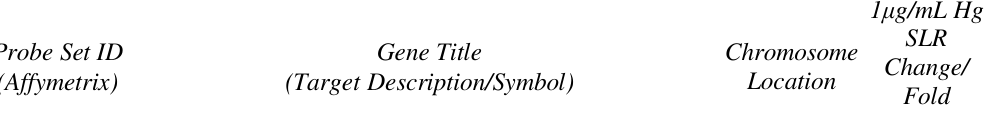
Table 1 contd.: Sample genes affected by mercury.